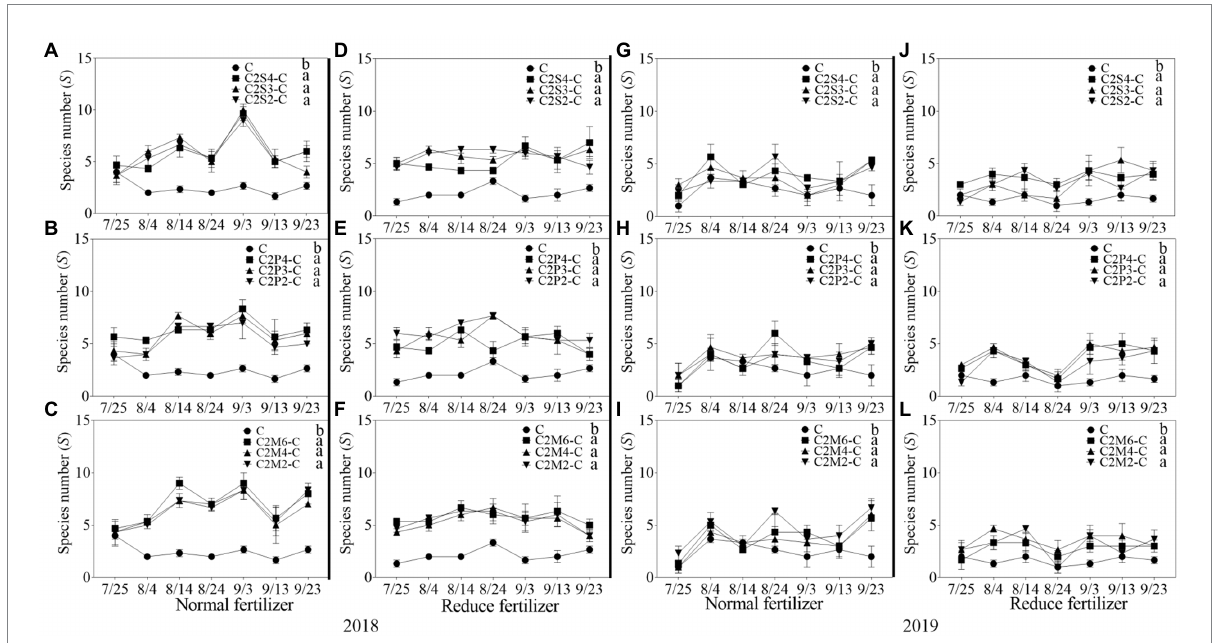
FIGURE 1 The average species number ( S ) each survey of insect communities on corn plants intercropping with soybean, peanut, and millet under different planting patterns at normal and reduced fertilizer. A-C represent corn-soybean intercropping, corn-peanut intercropping and corn-millet intercropping under normal fertilizer in 2018, respectively. D-F represent corn- soybean intercropping, corn-peanut intercropping and corn-millet intercropping under fertilizer reduction in 2018, respectively. G-I represents corn-soybean intercropping, corn-peanut intercropping and corn- millet intercropping under normal fertilizer in 2019, respectively. J-L represent corn-soybean intercropping, corn- peanut intercropping and corn- millet intercropping under fertilizer reduction in 2019, respectively. C2S2-C, C2S3-C, C2S4-C: corn plants in the planting patterns of 2 corn rows intercropping with 2, 3, 4 rows of soybean; C2P2-C, C2P3-C, C2P4-C: corn plants in the planting patterns of 2 corn rows intercropping with 2, 3, 4 rows of peanut; C2M2-C, C2M4-C, C2M6-C: corn plants in the planting patterns of 2 corn rows intercropping with 2, 4, 6 rows of millet. Different lowercase represents a significantly different average of the 7 evaluations among different planting patterns at the same fertilizer level and the same intercropping type by the LSD test at p < 0.05,